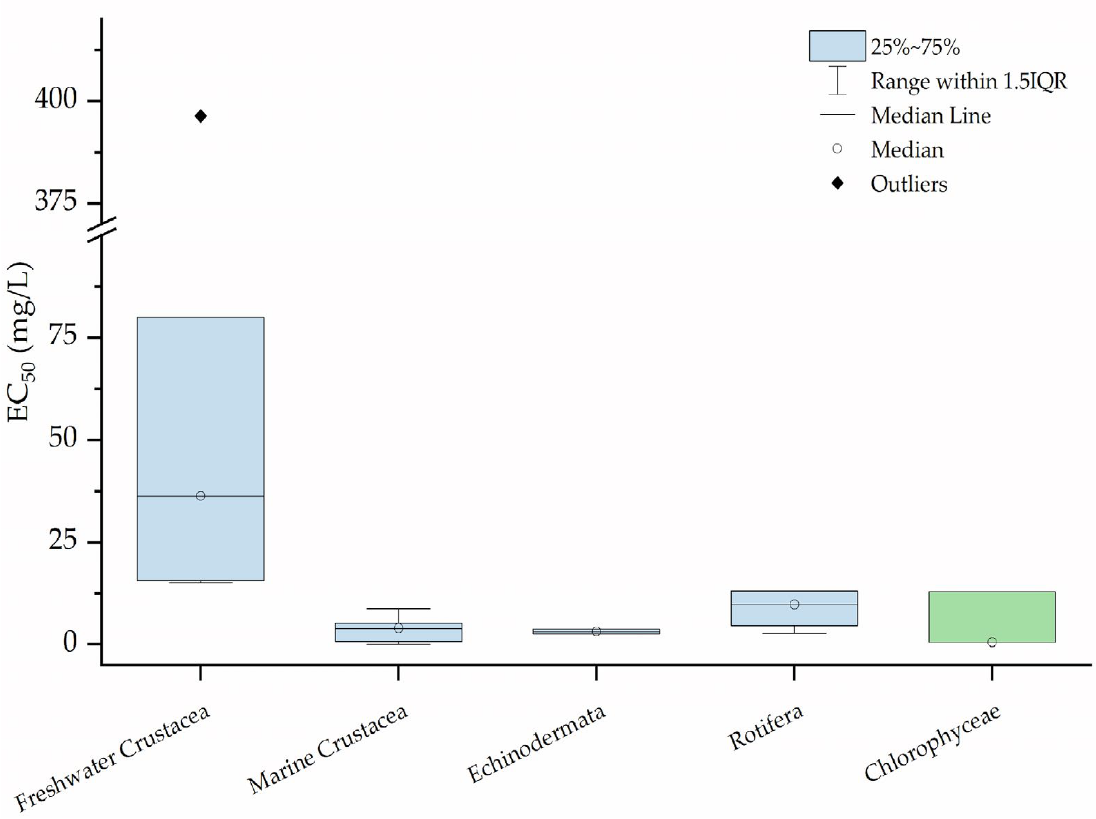
Figure 3. Lethal values (EC 50 ) expressed in mg · L − 1 of PS for different freshwater and marine taxa.